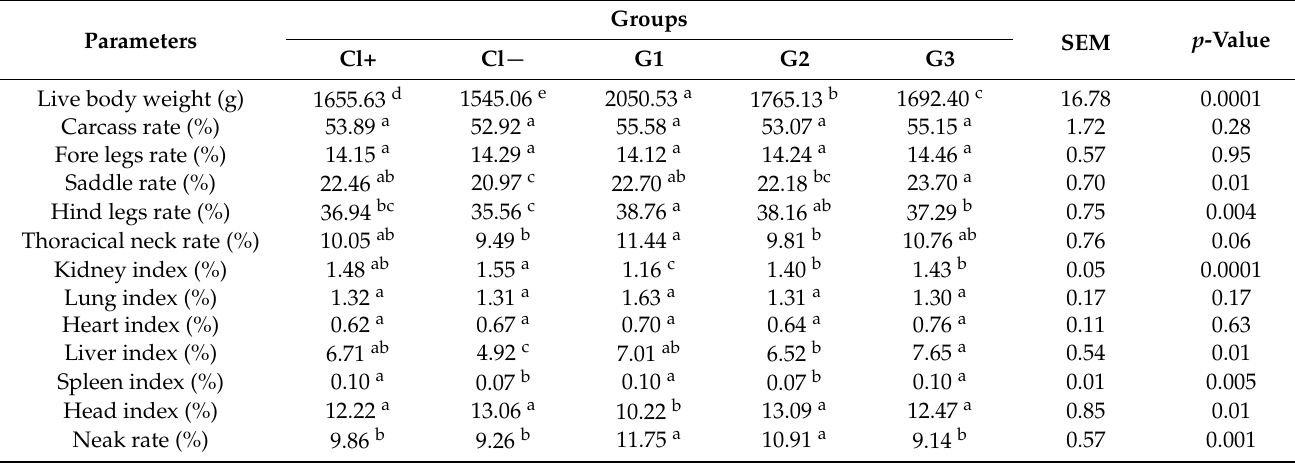
Table 6. Carcass traits relative to live bodyweight of rabbits as affected by yogurt supplementation with 1% of whey protein concentrate (WPC), Ca-caseinate (Ca-CN) and Spirulina platensis .